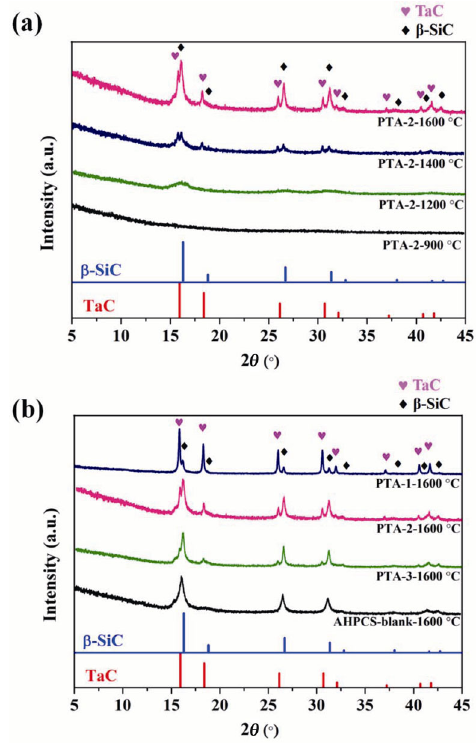
Fig. 4 XRD patterns of (a) PTA-2-derived ceramics annealed at different temperatures and (b) blank-AHPCS, PTA-1, PTA-2, and PTA-3-derived ceramics annealed at 1600 ℃ .